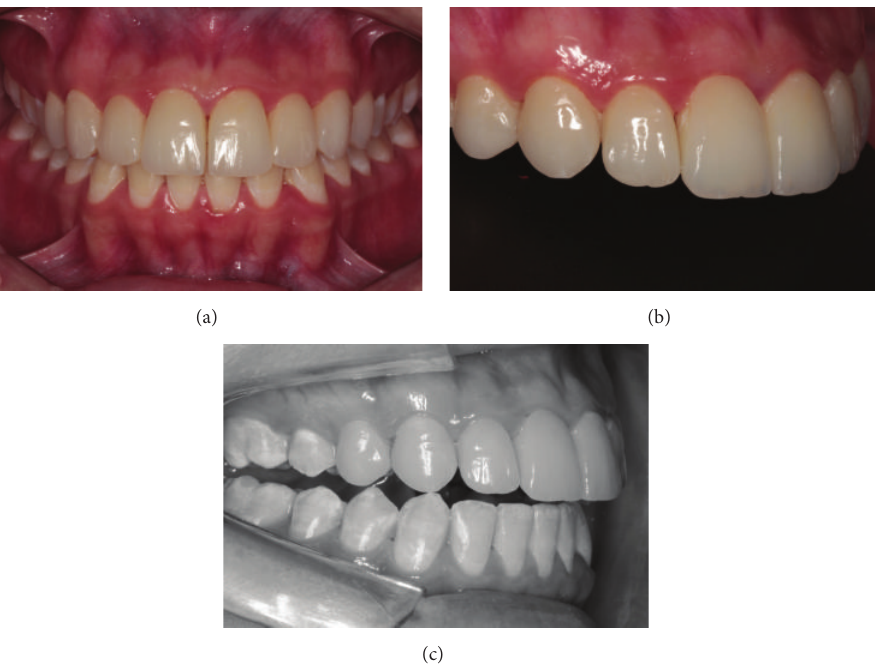
Figure 9: (a)–(c) Ceramic laminates after cementation. Note the disclusion due to the reestablished canine.